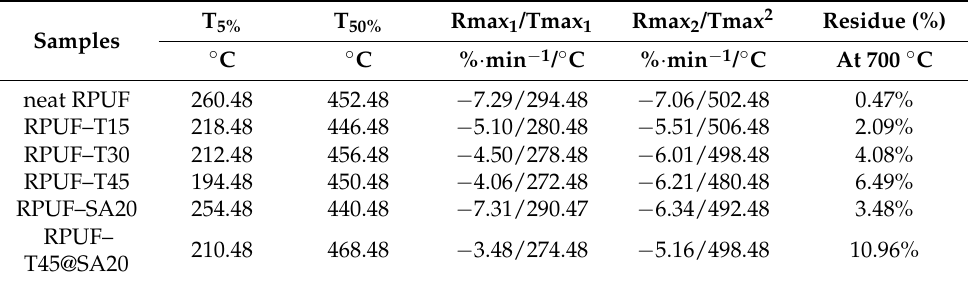
Table 4. TGA and DTG data of RPUFs under air.